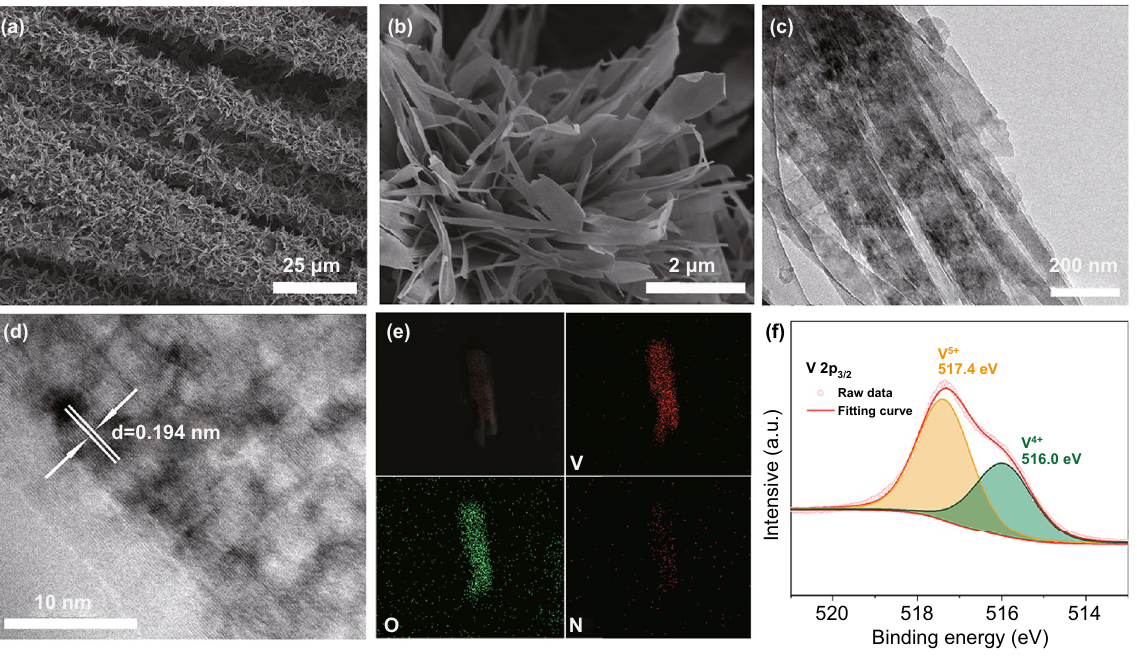
Fig. 2 Structural and morphological characterization of the NVO nanosheets. a, b SEM images, the ultrathin NVO sheets are grown on the car- bon cloth uniformly. c TEM and d HRTEM images, a lattice spacing of 0.194 nm corresponds to the spacing of (403) plane. e Elemental map- pings of N, O, and V. Few N elements are detected due to the loss of ammonium ions. f XPS spectrum of V 2p